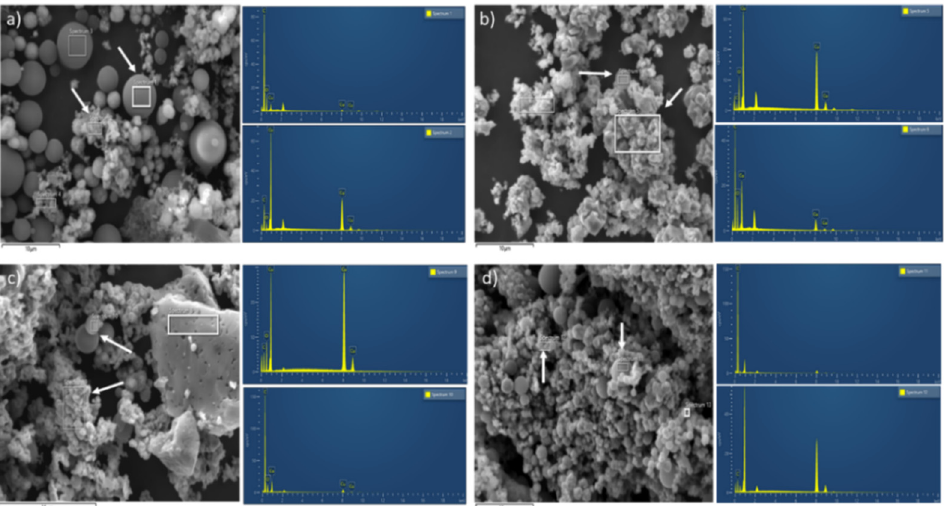
Figure 2. Composition of SEM-EDS analysis of Cu-based catalysts. ( a ) Cu4; ( b ) Cu4-350-O 2 ; ( c ) Cu4-550-O 2 ; ( d ) Cu4-800-N 2 . Table 1. Summary of composition (weight %) of catalysts from EDS analysis using the spectrums indicated in Figure 2.